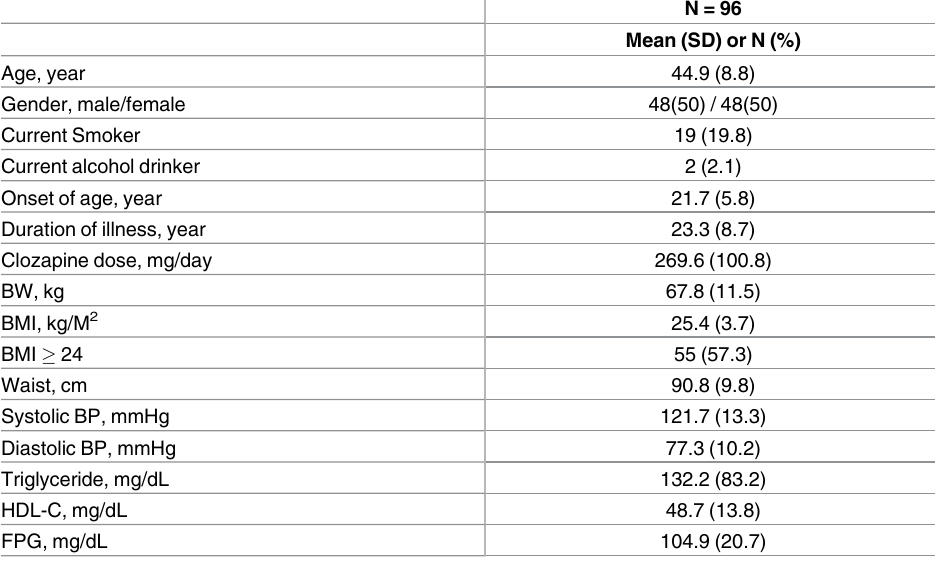
Table 1. Demographic, clinical characteristics, and baseline metabolic profiles in all screened patients.